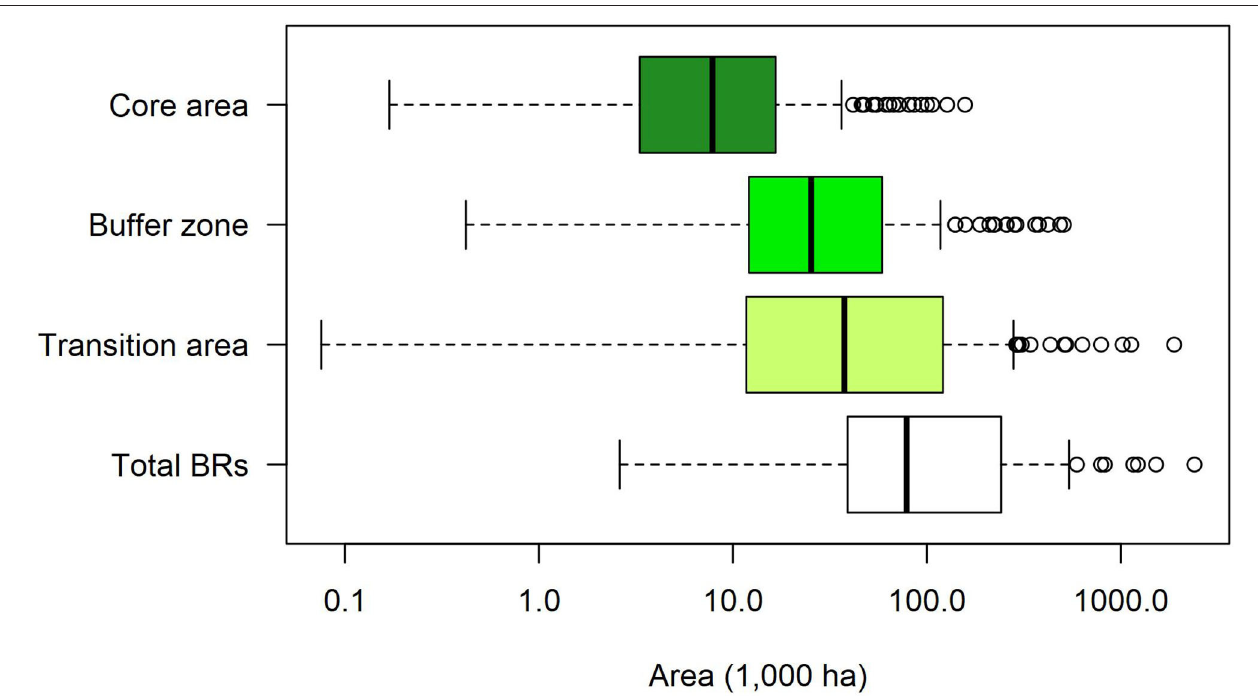
FIGURE 2 | Size distribution of biosphere reserves total area and zones (core area, buffer zone, transition area) across the 153 digitized reserves in Europe. Boxplots depict median values (thick black line) and first and third quartiles (box